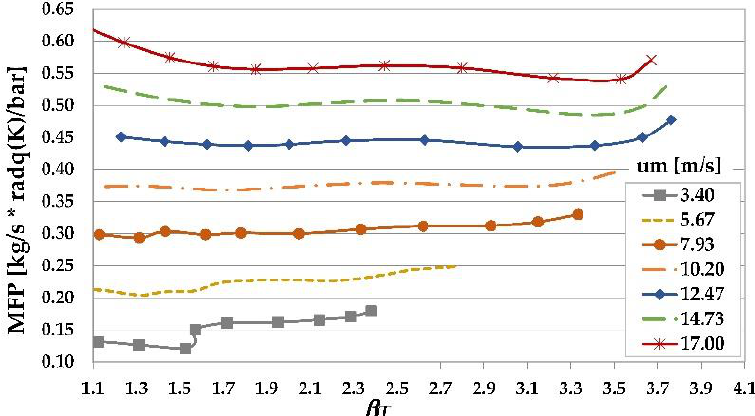
Figure 2. Operating points of the exhaust gas turbine for the separated electric compound engine studied in [4] (mass flow parameter as a function of the turbine pressure ratio β T ).